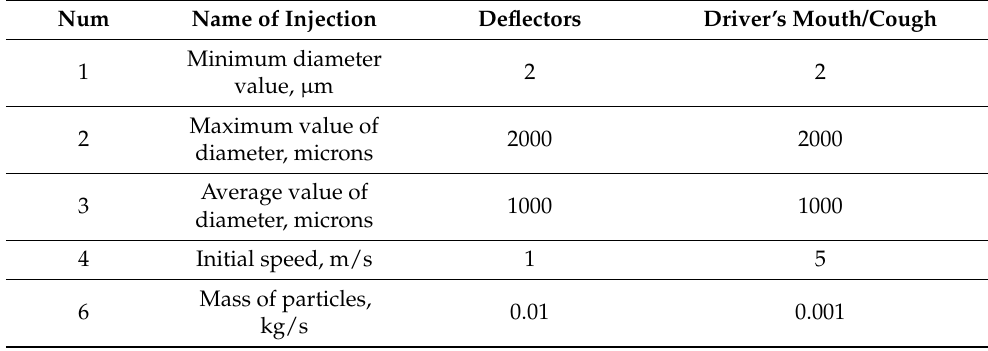
Table 3. Particle